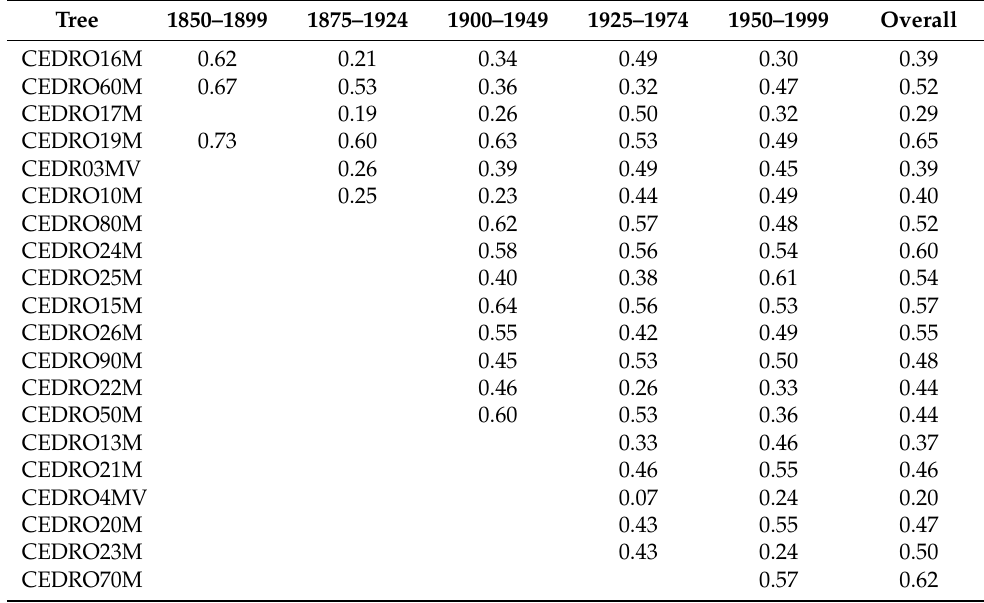
Table 1. Correlation (Spearman’s rho) of tree-ring series with master series. Tree